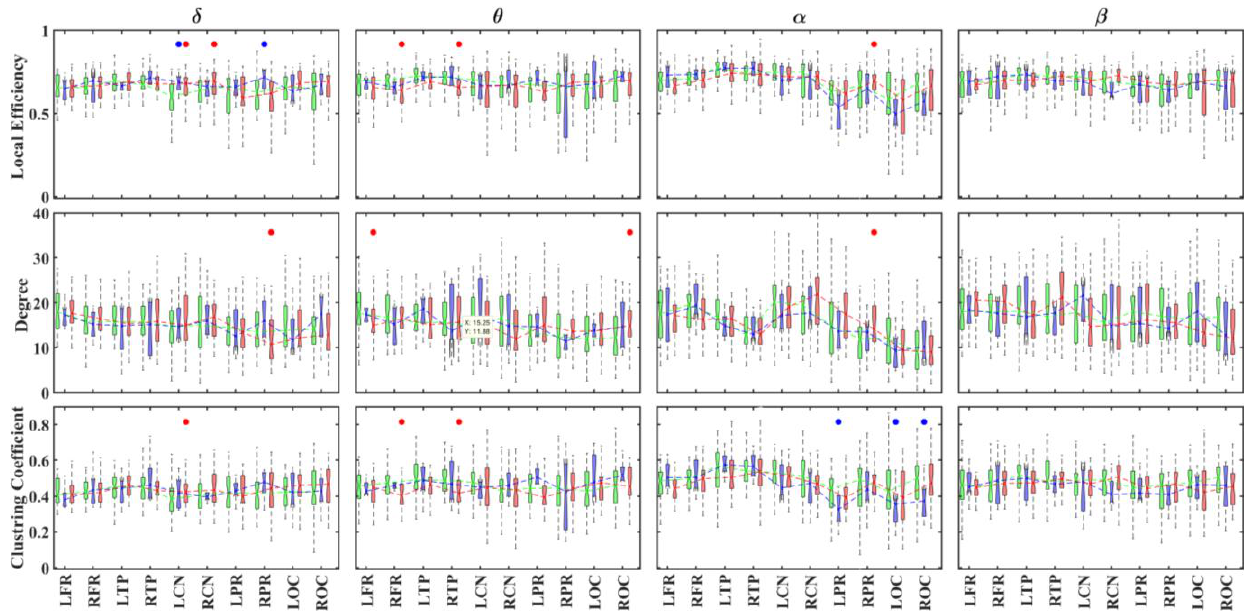
Figure 10. Boxplots displaying the median and interquartile ranges of the local degree, clustering coefficient and efficiency for each brain region and group (TD: green; ADHD I : blue; ADHD C : red) in different frequency bands. The points indicate statistically significant differences ( p < 0.05, 1000 permutations) between the ADHD C and TD groups (red) and between the ADHD I and TD groups (blue). R/L: right/left; FR: frontal regions; TP: temporal regions; CN: central regions; PR: parietal regions; OC: occipital regions.